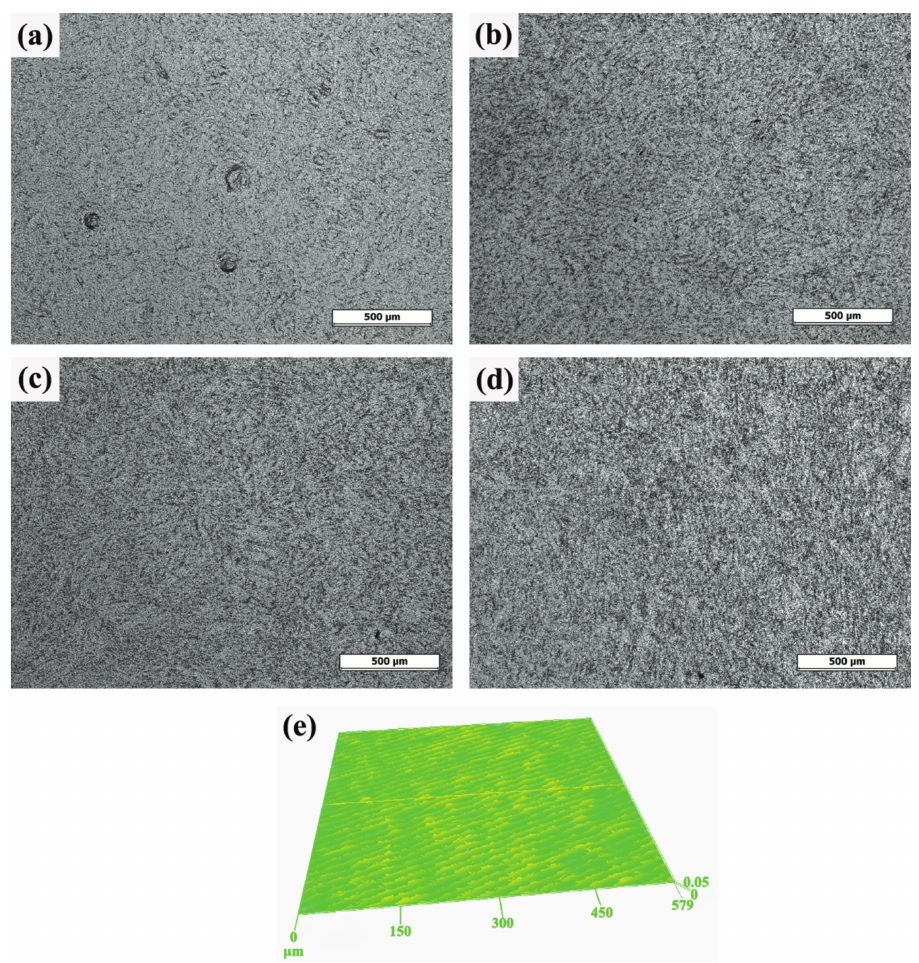
Figure 2: Optical micrographs taken on the HCPEB-treated pure zirconium with (a) 1, (b) 5, (10), and (d) 20 pulses,